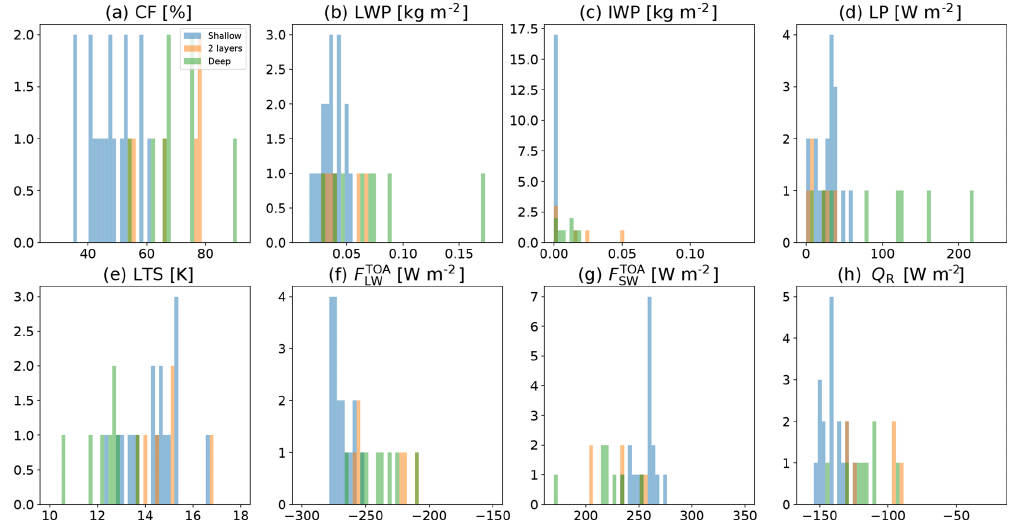
Figure 6. Histograms of mean (time and space) cloud and atmospheric properties for the base simulations with CDNC = 20cm − 3 (clean simulations) for each day of the NARVAL 1 month (December 2013) separated into different cloud regimes: shallow clouds (blue), two-layer clouds (shallow clouds with cirrus clouds layer above – orange), and deep clouds (green). (a) Cloud fraction – CF, (b) liquid water path – LWP, (c) ice water path – IWP, (d) precipitation latent heat flux – LP, (e) lower-tropospheric stability – LTS, (f) top-of-atmosphere longwave flux – F TOA , (g) top-of-atmosphere shortwave flux – F TOA , and (h) atmospheric column radiative term – Q R . LW SW